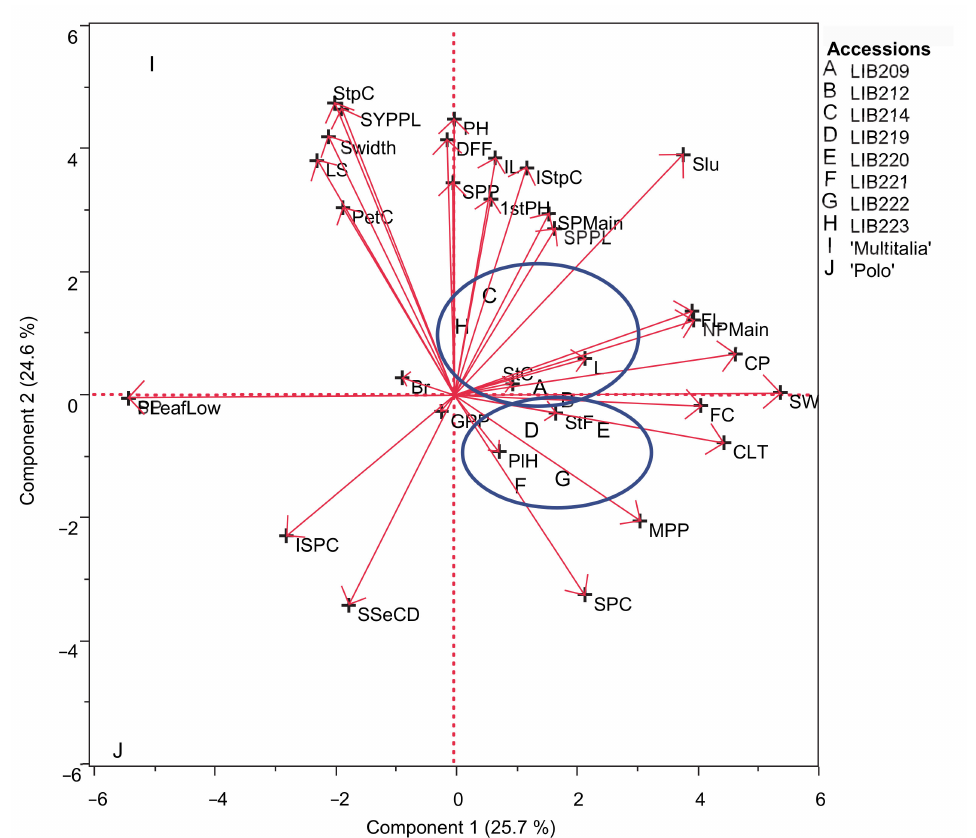
Figure 3. Two dimensional biplot of the two first components of the principal component analysis for eight L. mutabilis , one L. albus (‘Multitalia’) and one L. angustifolius (‘Polo’) accession. PLeafLow (pubescence of leaflet lower surface), ISPC (intensity of seed primary color), SSeCD (seed secondary color distribution), GPP (green pod pubescence), PlH (plant habit), SPC (seed primary color), MPP (mature pod pubescence), StF (stem formation), CLT (central leaflet tip), FC (color of flower), SW (stem waxiness), StC (stipule color), CP (seed crude protein content), NPPMain (number of pods in main inflorescence), FL (flower length), L (lodging), Slu (seed lustre), SPPL (seeds per plant), SPMain (seeds in main inflorescence), 1stPH (height of first pod), IStpC (intensity of stipule color), IL (inflorescence length), SPP (seeds per pod), DFF (days to first flowering), PH (plant height), PetC (petiole color), LS (leaf shape), Swidth (seed width), SYPPL (seed yield per plant), StpC (stipule